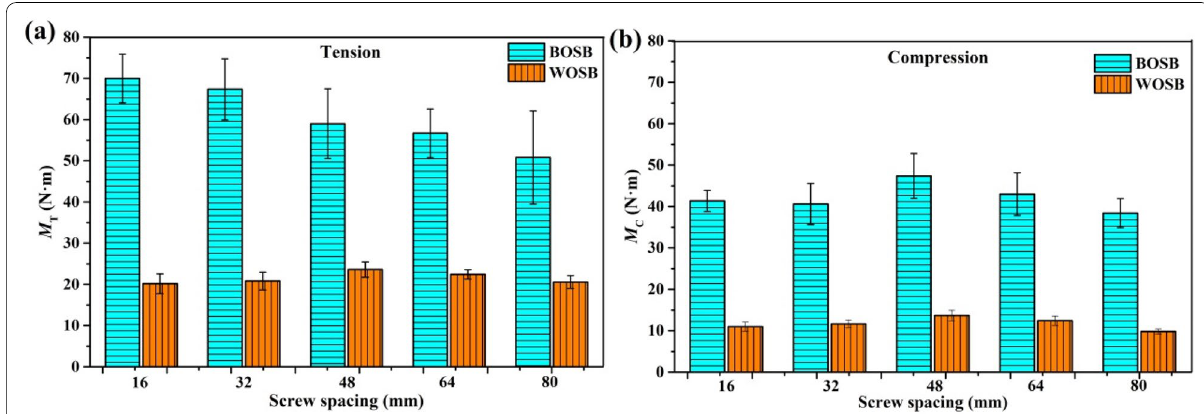
Fig. 7 Bending moment of joints at: a tension, b